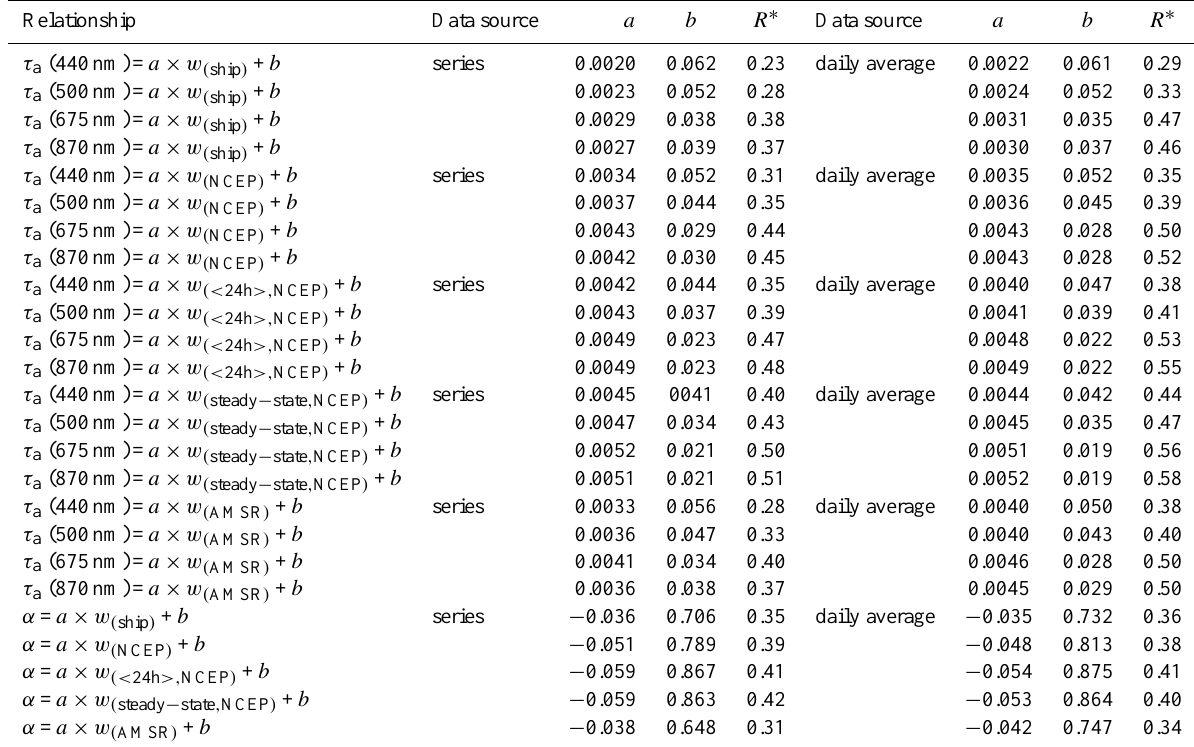
Table 2. Regression statistics of spectral optical parameters versus wind speed.